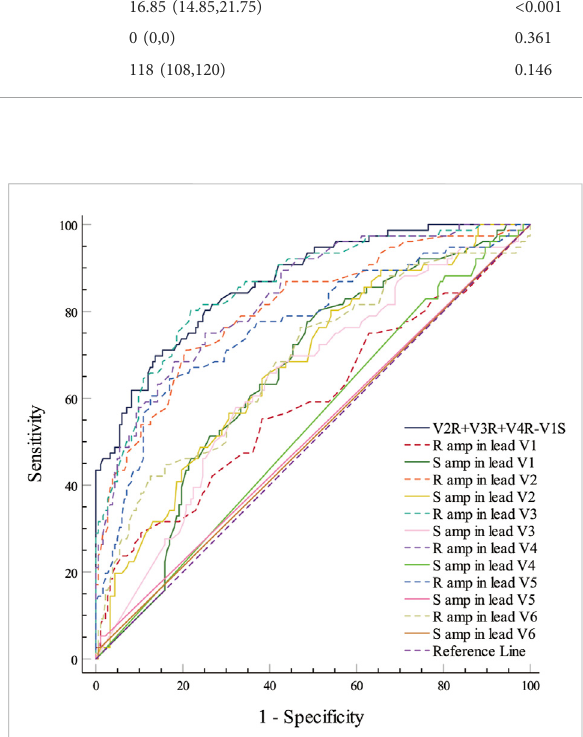
FIGURE 2 ROC curve analysis show the predictive accuracy of R-S difference index (V2R+V3R+V4R − V1S). R-S difference index was calculated from the R-wave amplitude in lead V3 with the greatest AUC of 0.0.856, followed by those in leads V4 and V2 (0.834 and 0.806, respectively). A joint logistic regression analysis model yielded an AUC value of 0.867 for V2R+V3R+V4R − V1S. ROC,Receiveroperatingcharacteristic;Ramp,R-waveamplitude; S amp, S-wave